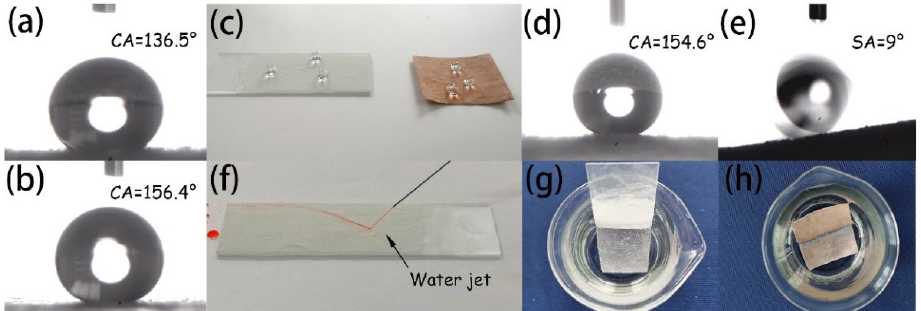
Figure 1. ( a ) Contact angle of coating A. ( b ) Contact angle of coating B. ( c ) Digital image of water droplets on the surface of copper foil and glass slide covered by coating C. ( d ) The contact angle (CA) of the glass slide surface covered by coating C. ( e ) The sliding angle (SA) of the glass slide surface covered by coating C. ( f ) Water jet reflection on the glass slide surface covered by coating C. ( g ) Digital photo of glass slide covered by coating C in water. ( h ) Digital photo of copper foil covered by coating C in water.